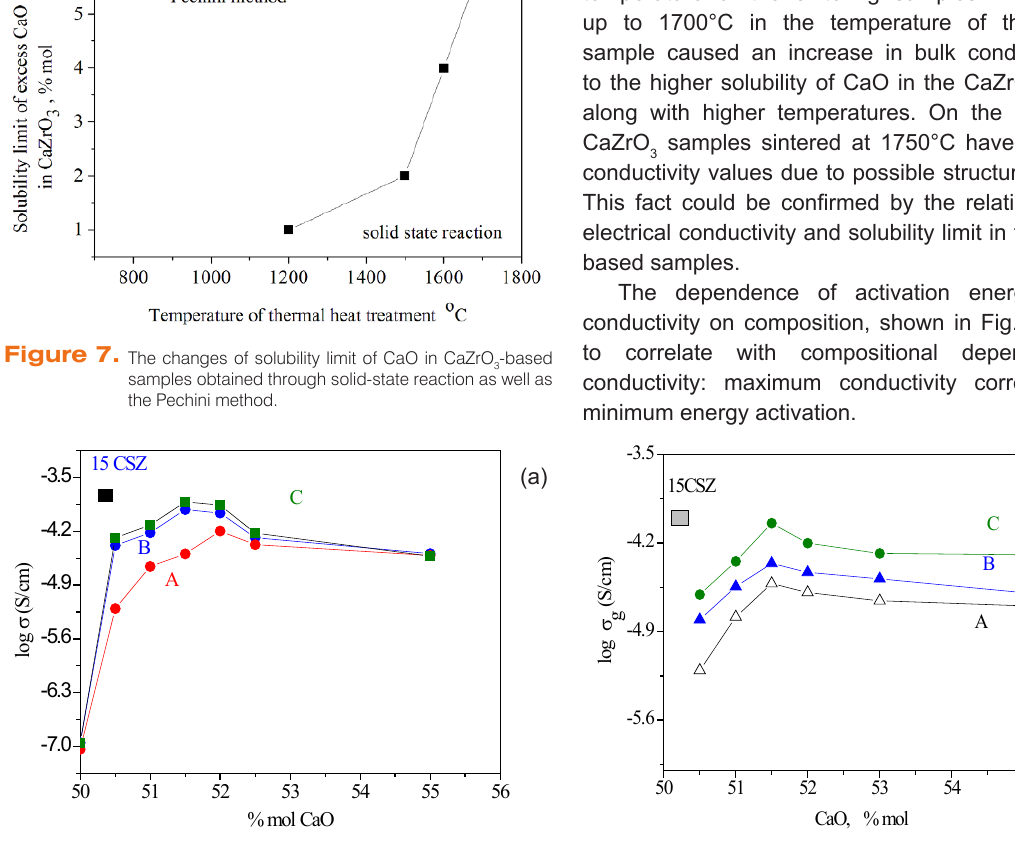
Figure 8. (a) The dependence of bulk conductivity for CaZrO3-based samples recorded at 700°C; A – solid state reaction, B – citrate method, C – Pechini method; 15CSZ-cubic zirconia solid solution involving 15% mol CaO; (b) The dependence of grain boundary conductivity for CaZrO3-based samples recorded at 700°C; A – solid state reaction, B – citrate method, C – Pechini method; 15CSZ-cubic zirconia solid solution involving 15% mol